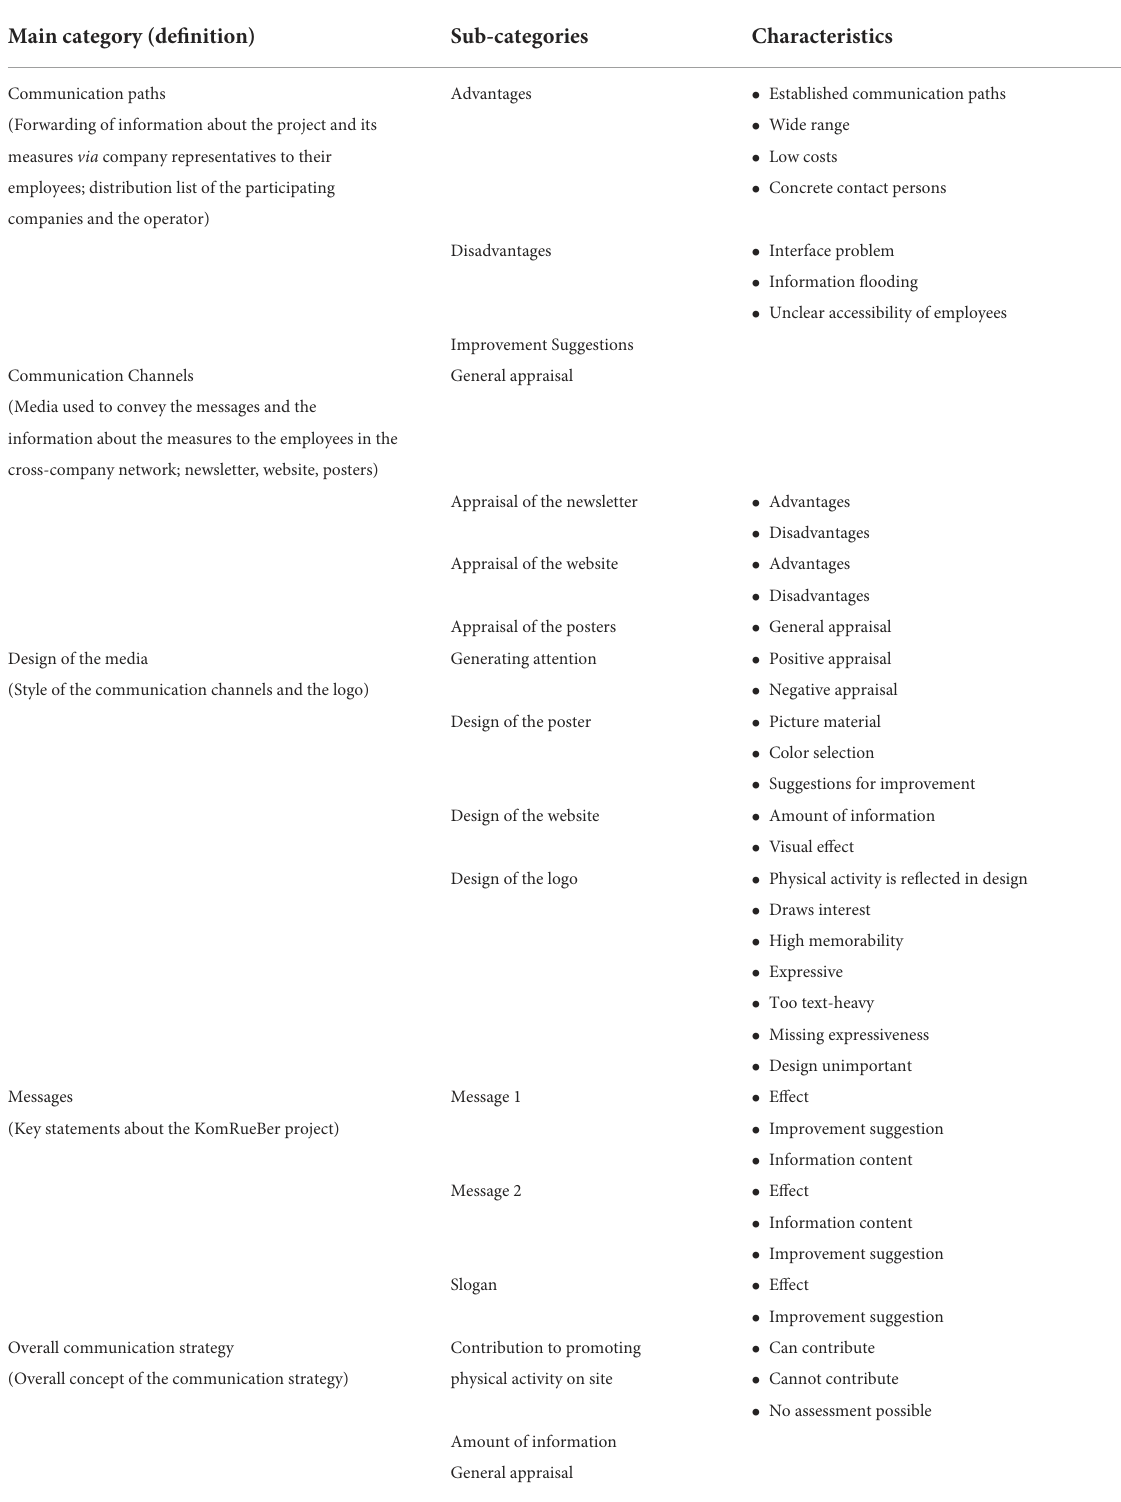
TABLE 4 Coding system: appraisal of the communication